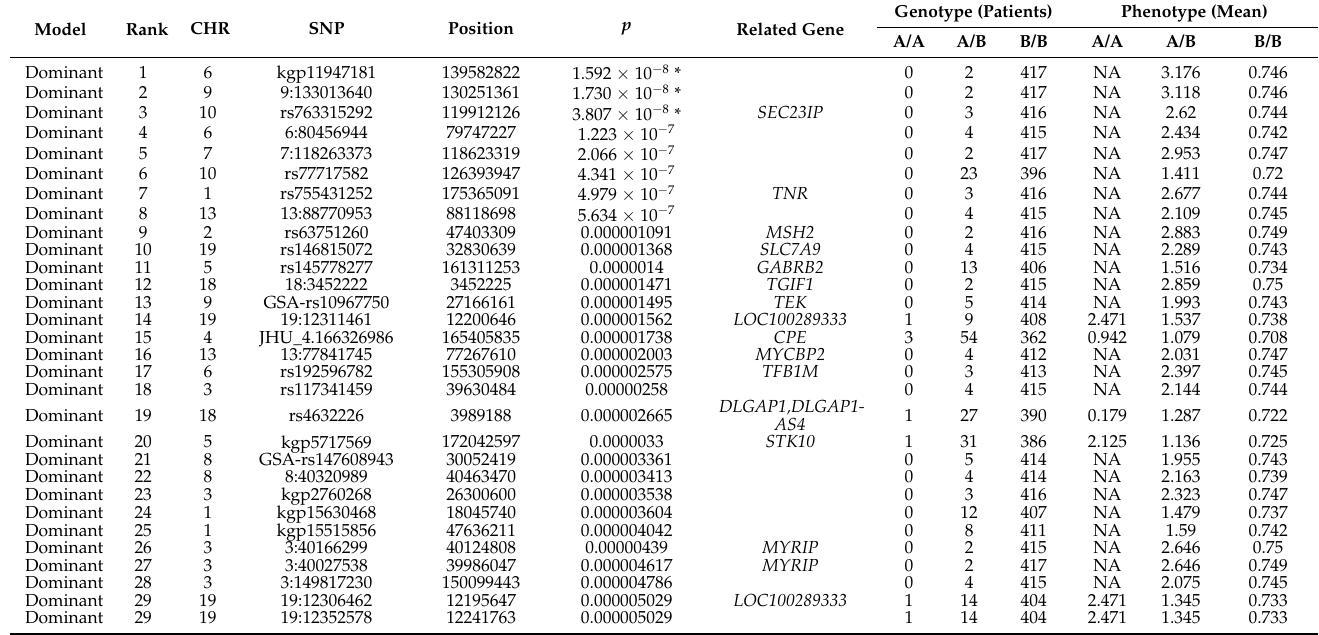
Table 3. Top 30 candidate SNPs selected from the GWAS (dominant